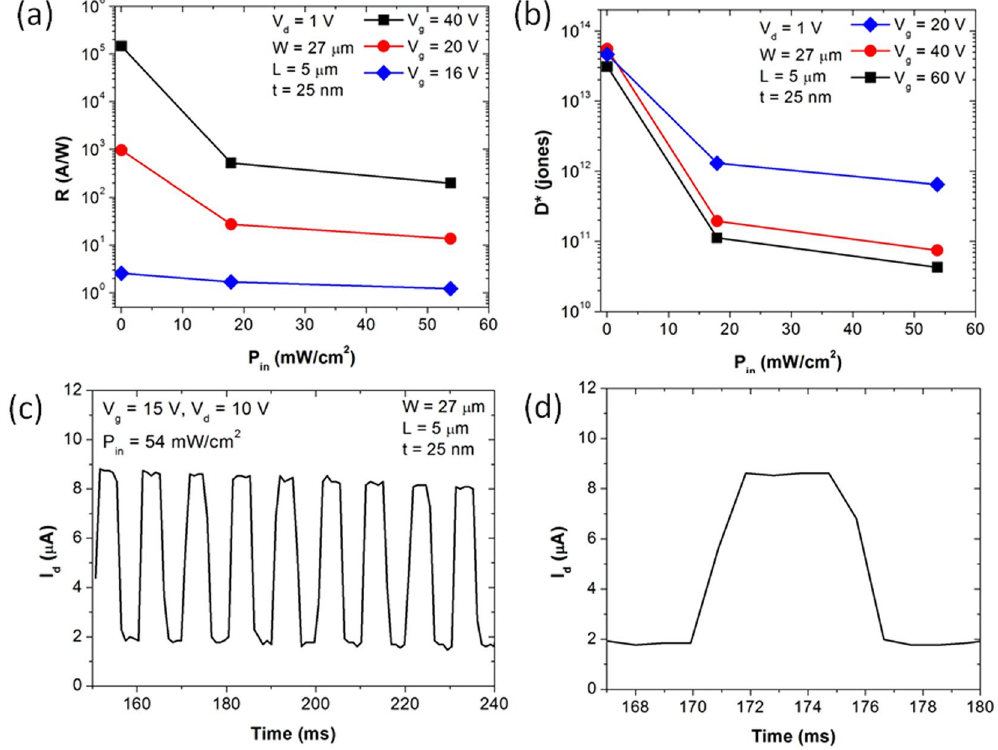
Figure 4. ( a ) R and ( b ) D * as a function of P in at different V g ; ( c ) I d as a function of time and ( d ) zoomed-in region in ( c ).